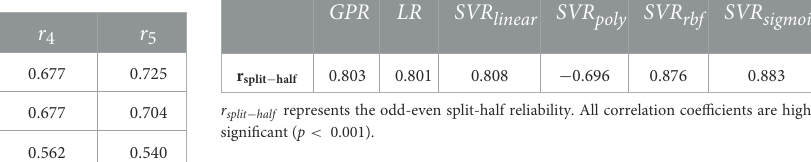
RMSE , root mean square error. r All , r Male and r Female represent the criterion validity of the model for all participants, male participants, and female participants, respectively. All correlationcoefficientsarehighlysignificant( p < 0.001). TABLE 6 The odd-even split-half reliability of anxiety assessment